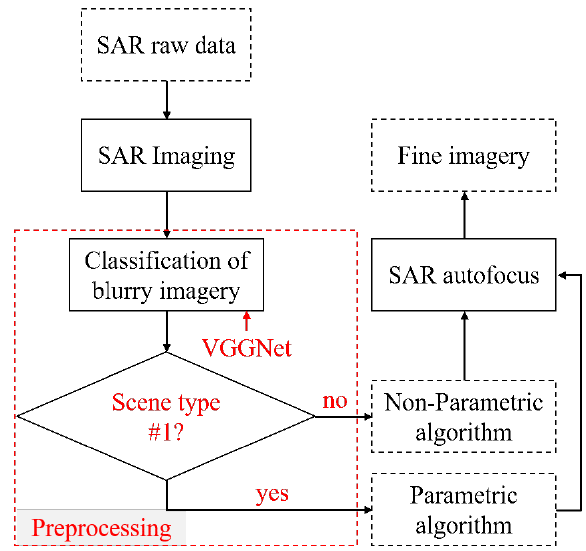
Figure 3. Flowchart of the proposed autofocus